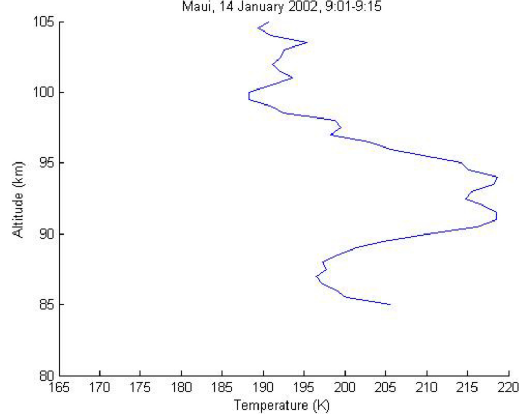
Fig. 6. Temperature profile averaged for about 15min during the overturning event on 14 January